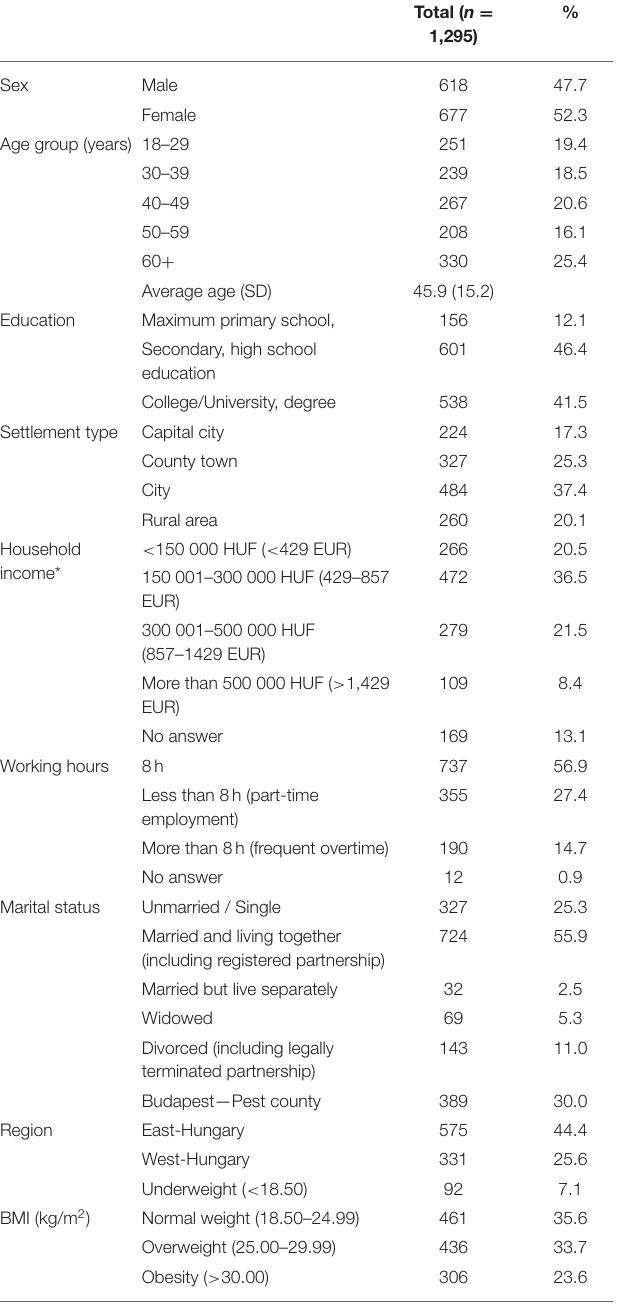
TABLE 1 | Distribution of the sample by sex, age, education, settlement type, regions, marital status, household income, daily working hours, BMI and the average age of the sample with standard deviation.